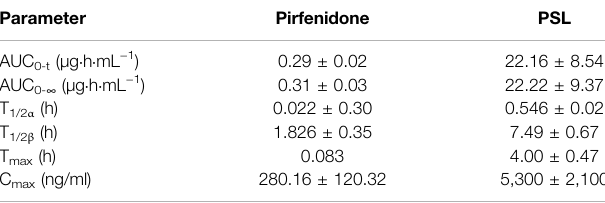
TABLE 1 | Pharmacokinetic parameters of pulmonary administration of pirfenidone and PSLs in rats (4 mgkg − 1 ) ( n = 6). Parameter